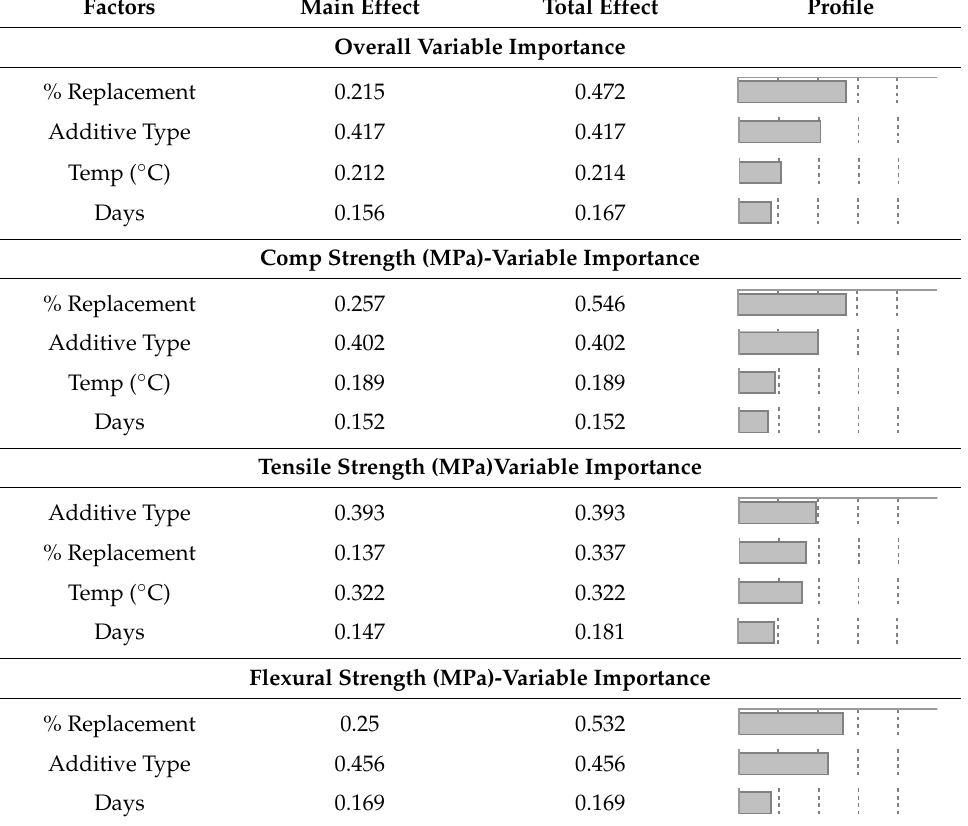
Table 9. Variable importance and impact of all strength parameters.